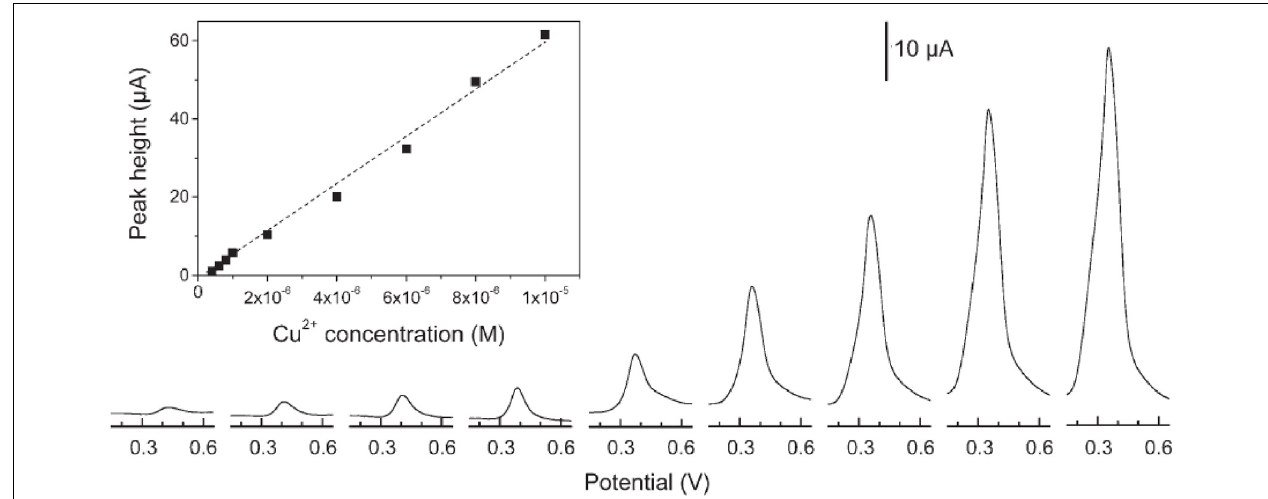
FIGURE 4 | Typical DPASV and calibration (inset panel) curves obtained for Cu 2 + using a 10% amine functionalized silica film deposited on gold. Reprinted with permission from Walcarius and Sibottier (2005). Copyright 2005